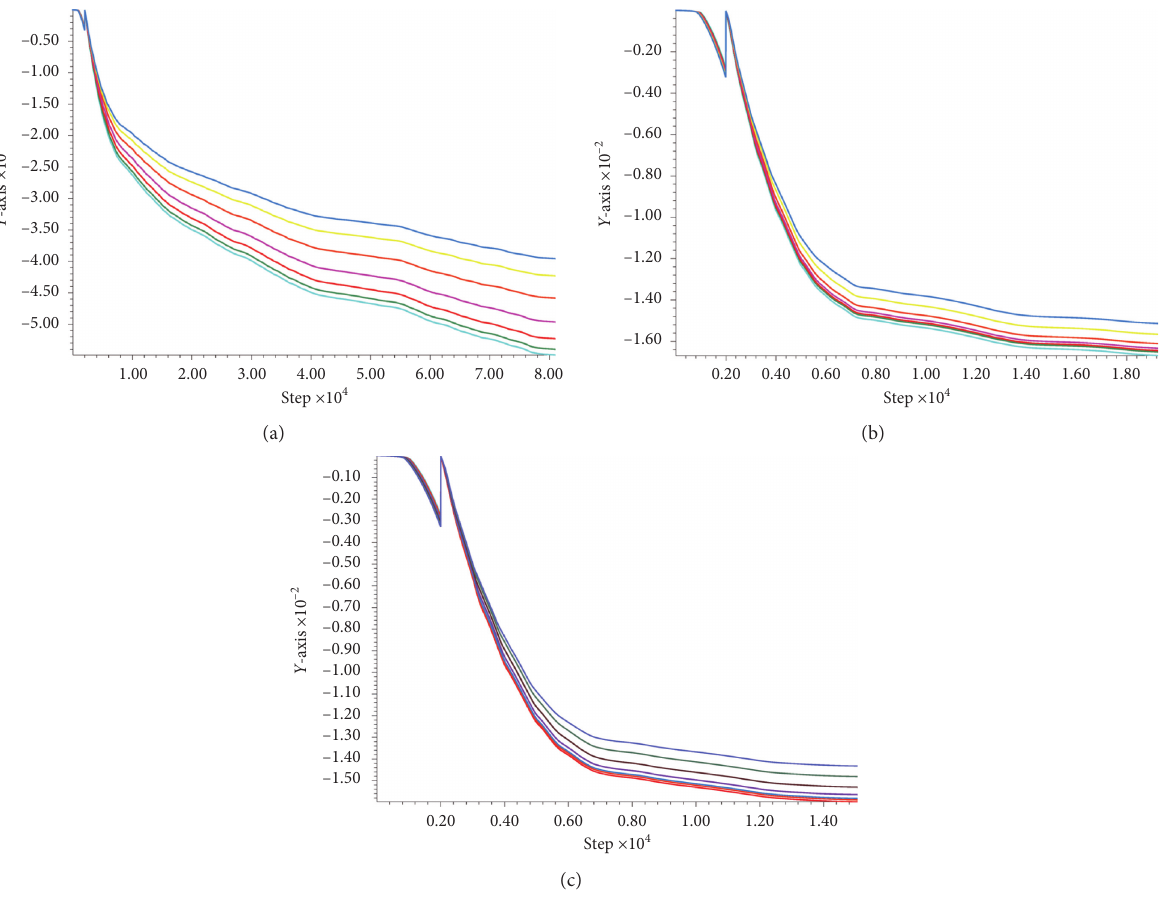
Figure 7: Maximum displacement of the roof under different support forms. (a) No support state. (b) Supporting state of non-truss anchor cable. (c) Support state of truss anchor